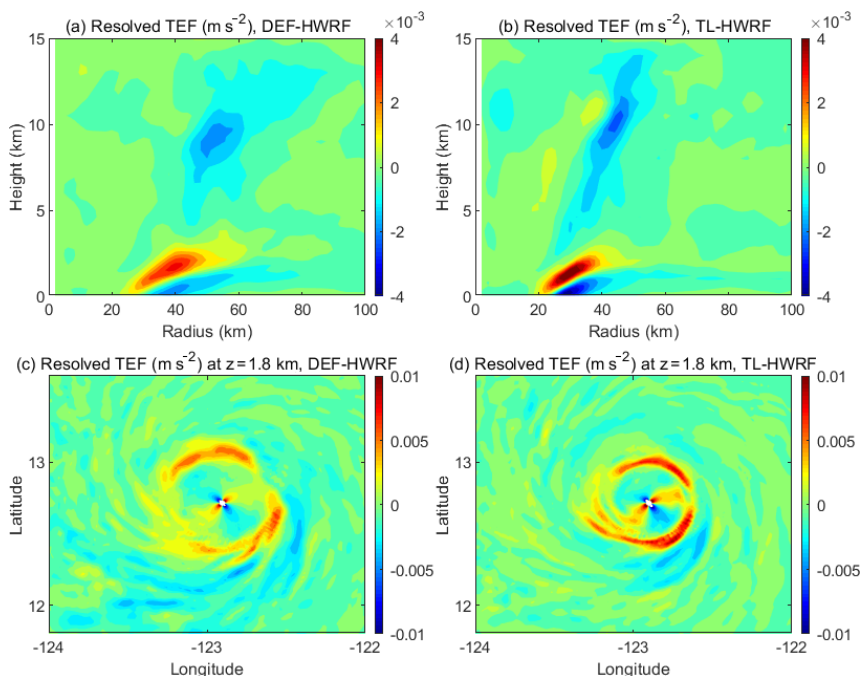
Figure 12. Model-resolved tangential eddy forcing (TEF) averaged over Jimena’s RI period from 06:00UTC, 28 August, to 06:00UTC, 29 August 2015, from the two HWRF simulations (DEF-HWRF and TL-HWRF). (a, b) Azimuthal-mean radius–height structure of resolved TEF. (c, d) Horizontal structure of resolved TEF at 1.8km